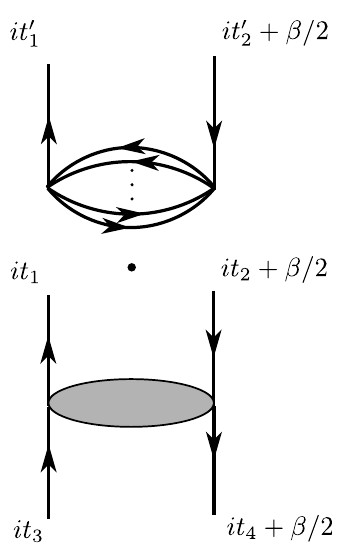
Figure 6 . Retarded kernel acts on a four-point function in complex